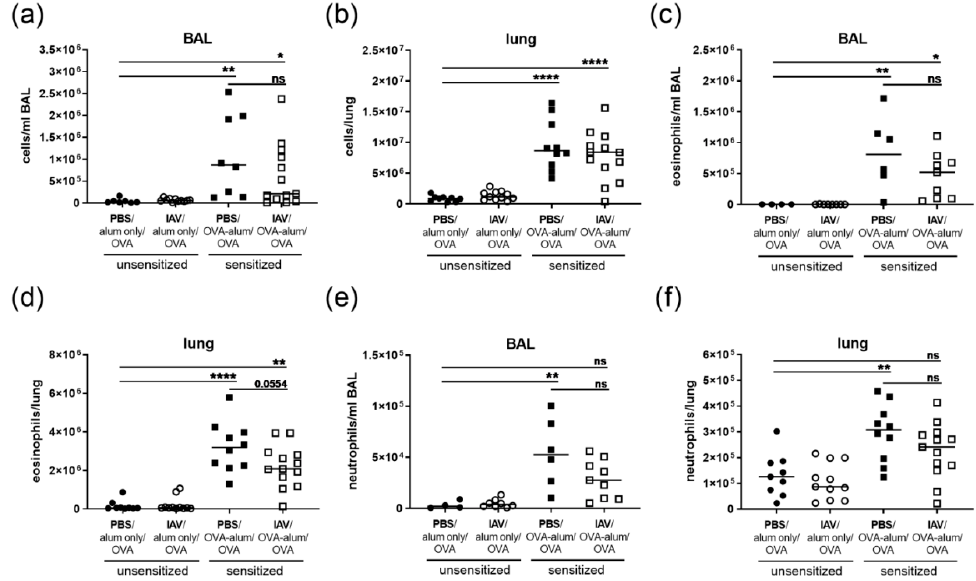
Figure 5. Resolved IAV infection does not affect respiratory tract total cell and eosinophil numbers but reduces respiratory neutrophils in AAI. Mice were infected i.n. with a sublethal dose of IAV or treated with PBS on day 0, were sensitized against OVA i.p or mock-sensitized with alum only i.p. on days 14, 21 and 28 and all mice were challenged i.n. with OVA on days 35, 36 and 37. On day 39 post infection, total leukocyte numbers in the BAL ( a ) and lungs ( b ), eosinophil numbers in the BAL ( c ) and lungs ( d ) and neutrophil numbers in the BAL ( e ) and lungs ( f ) were flow cytometrically analyzed. Data are shown for individual mice together with the group median. BAL data are compiled from two to three independent experiments and lung data are compiled from three independent experiments. * p < 0.05, ** p < 0.01, **** p < 0.001, ns = not significant.